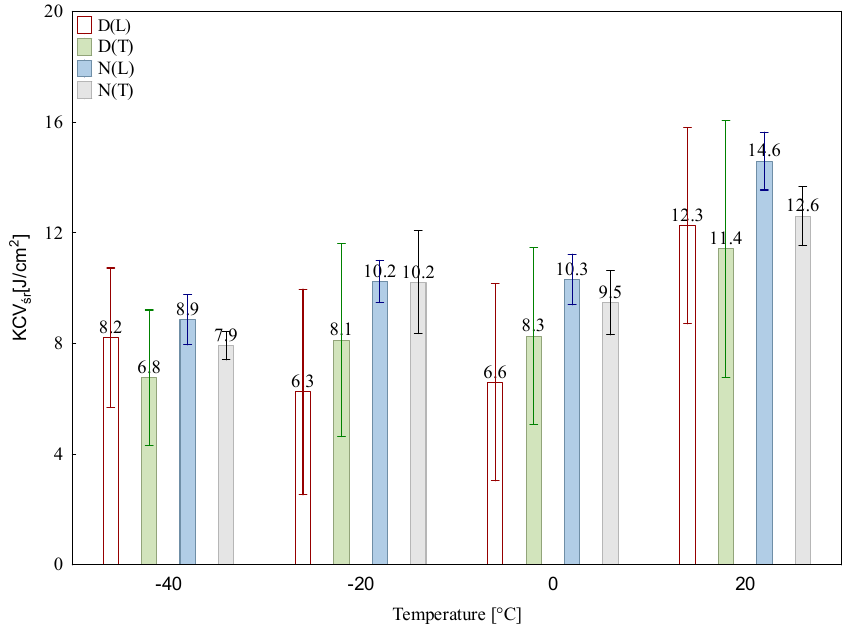
Figure 8. Changes in the impact strength of Hardox Extreme steel as a function of temperature in delivery and normalized states.